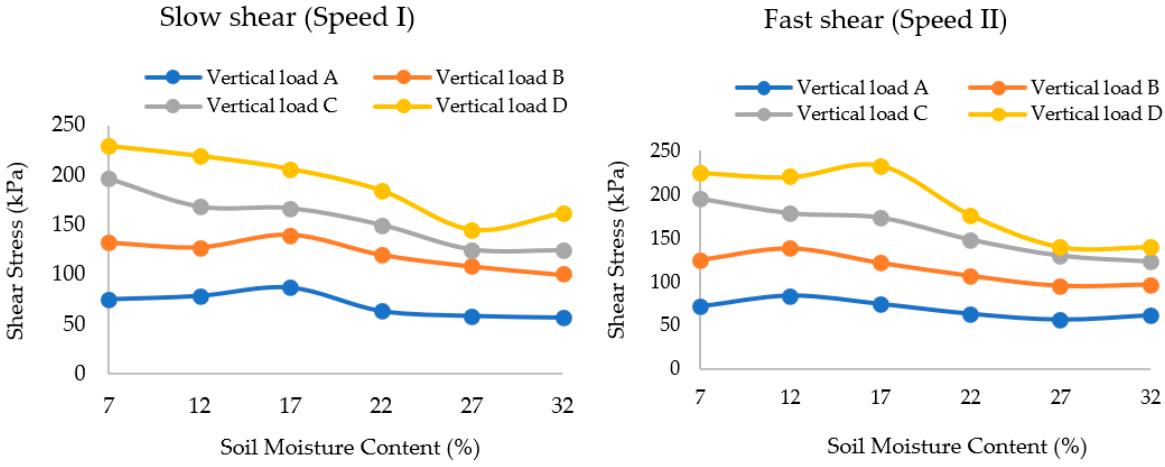
Figure 9. The changing trend of shear stress with the increase in moisture